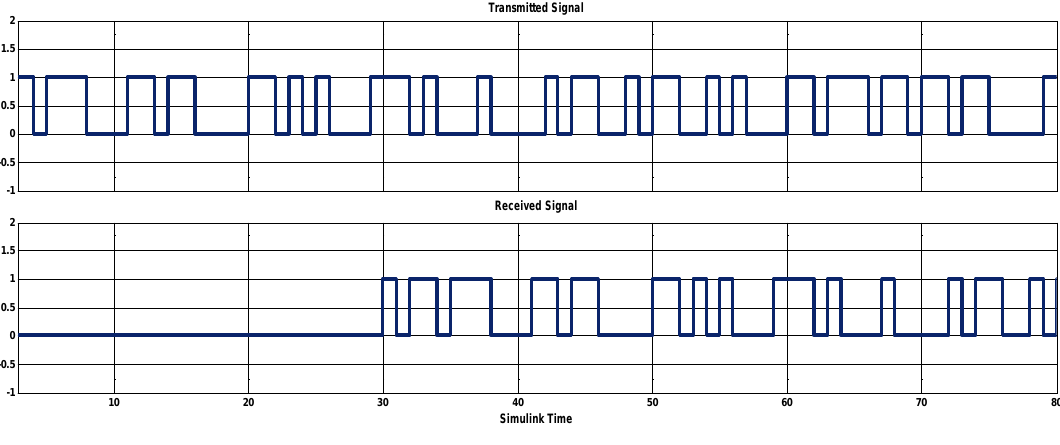
Fig. 19. The simulated output of the MS decoder algorithm's data recovery signal processing.